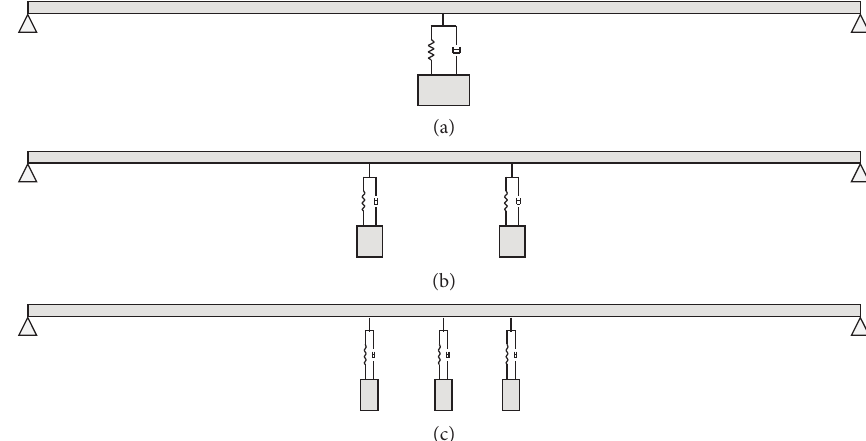
Figure 3: (a) Scenario 1: 1 TMD with the total TMD mass, (b) Scenario 2: 2 TMDs with half of the total mass each, and (c) Scenario 3: 3 TMDs with one-third of the total mass